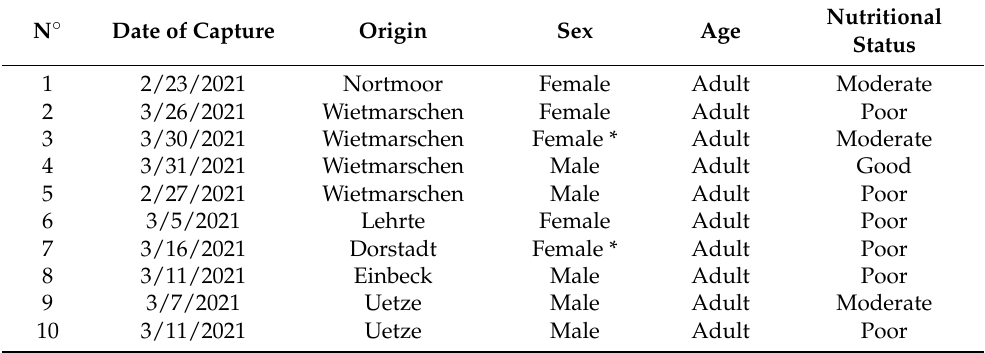
Table 1. Coypus ( Myocastor coypus ) examined in the present study, including animal number, date of capture, origin, sex, age and nutritional status. *: